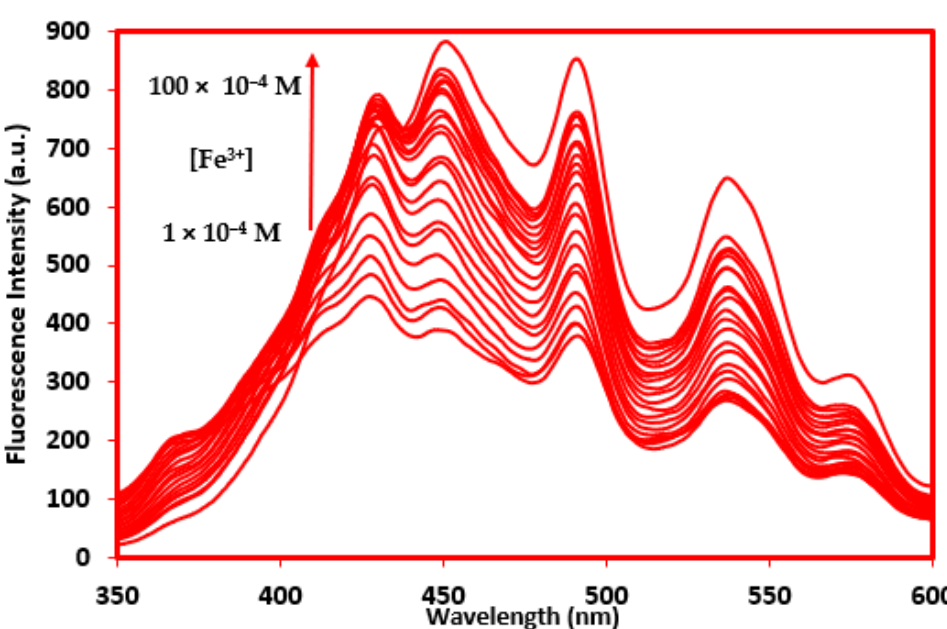
Figure 9. Fluorescence response of SBA-Pr-Is-TAP (3 mL H ₂ O suspension, 0.2 g L − ¹) by adding different concentrations of Fe³ ⁺ .